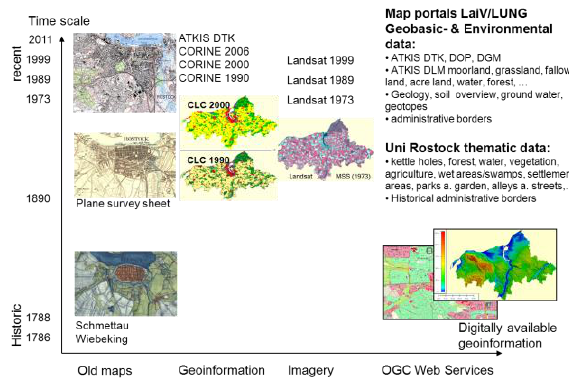
Figure 4. Used base maps and data sources.